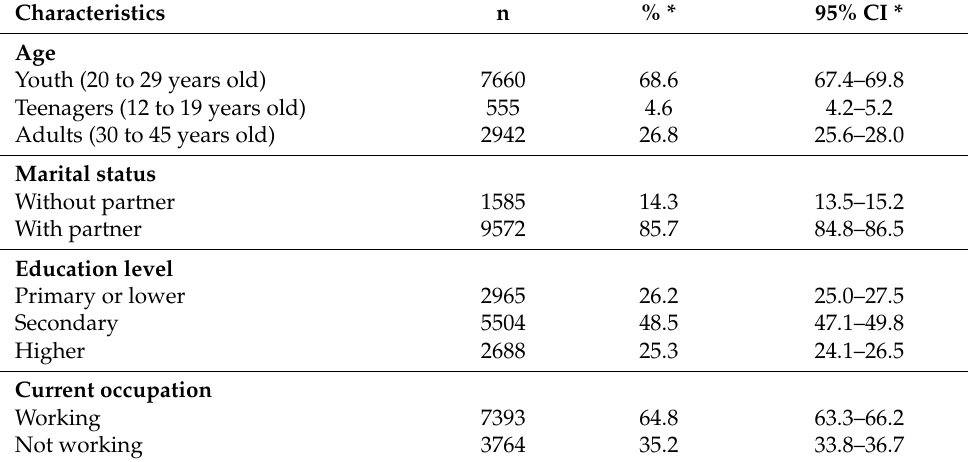
Table 1. General characteristics of the study population (n =